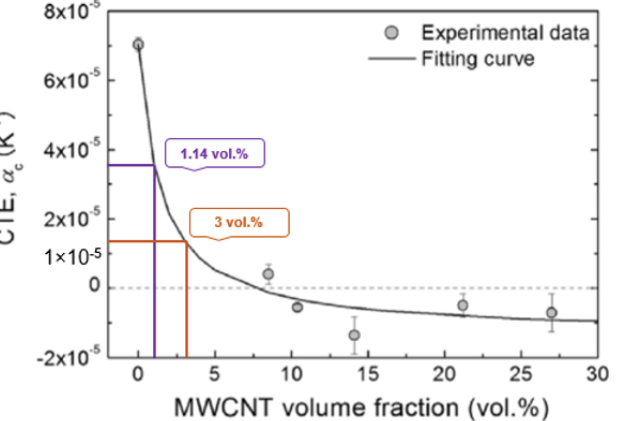
Figure 8. Coefficient of thermal expansion with 1.14 vol% and 3 vol% MWCNTs [11].